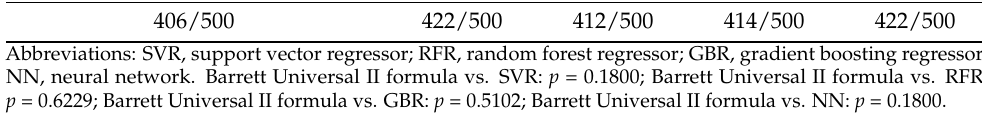
Table 3. Proportion of objects with errors less than 0.5 D. Table 4. Means of five cross validation for Characteristic Importance of